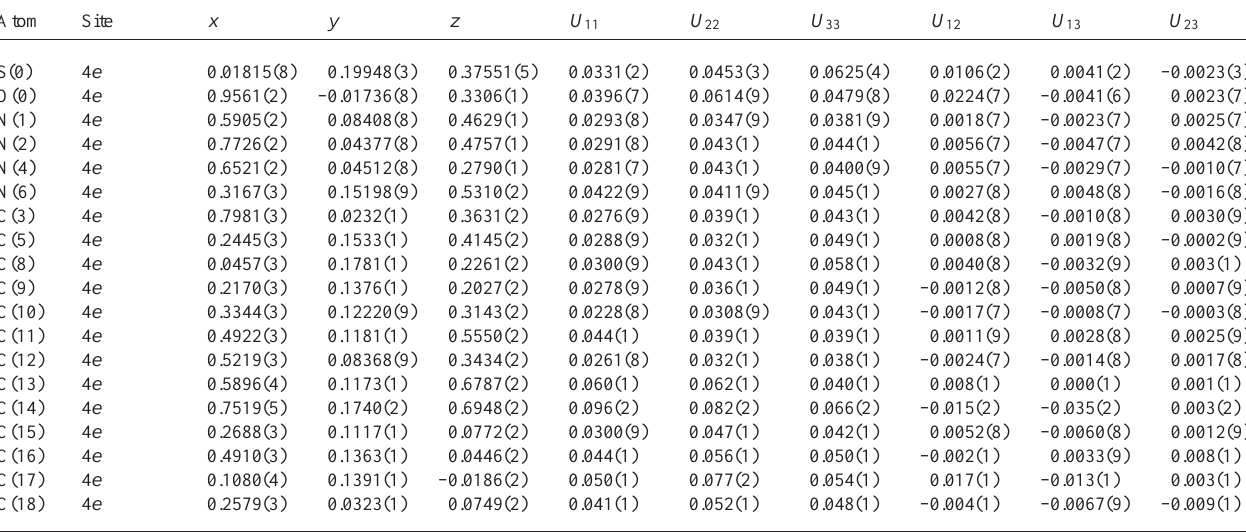
Table 3. Atomic coordinates and displacement parameters (in Å 2 )